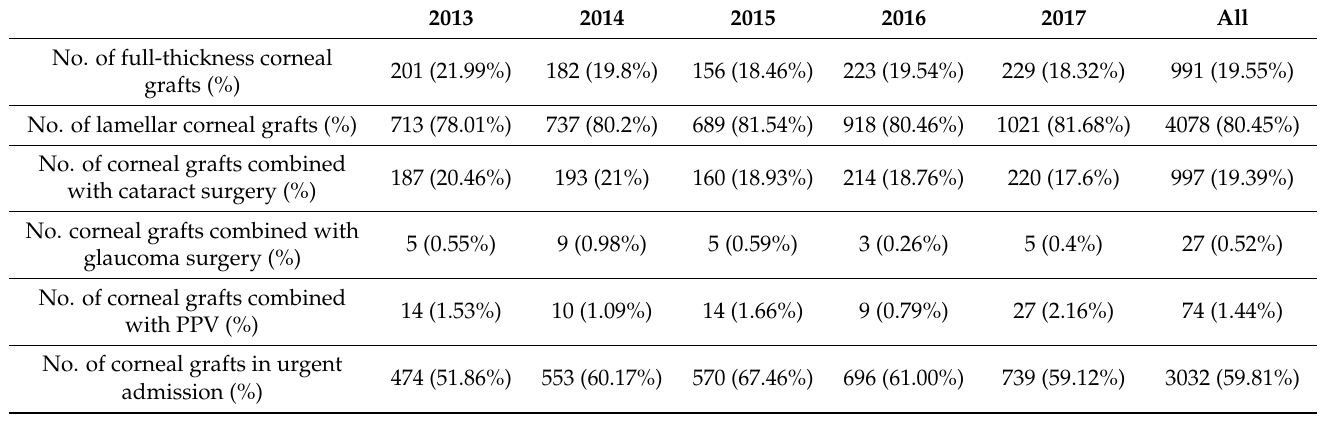
Table 4. Clinical characteristics of corneal grafts in Poland from 2013 to 2017.